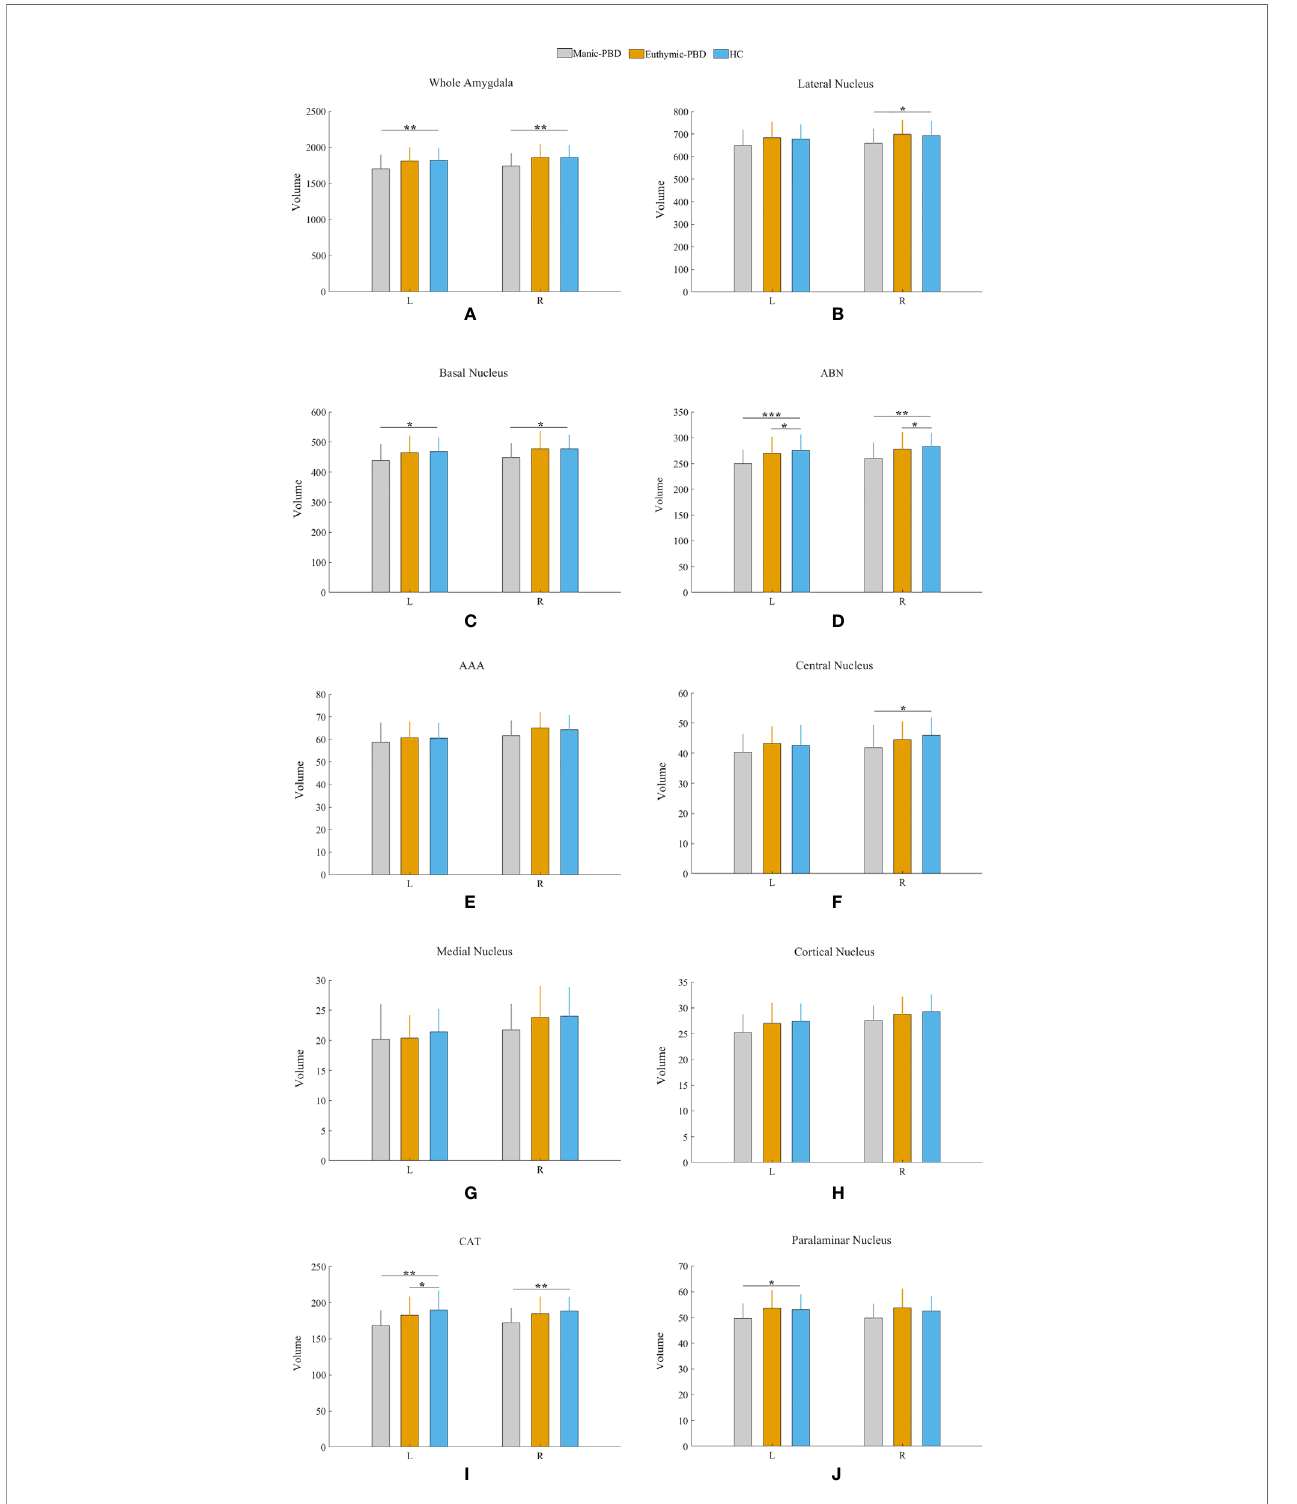
FIGURE 2 | Pairwise comparison of volumes in the manic PBD group, euthymic PBD group, and healthy control group ( A ,Whole Amygdala volume; B , Lateral Nucleus volume; C , Basal Nucleus volume; D , ABN volume; E , AAA volume; F , Central Nucleus volume; G , Medial Nucleus volume; H , Cortical Nucleus volume; I , CAT volume; J , Paralaminar Nucleus volume). The Y-axis represents the mean volume of amygdala and its subnuclei in each group. Unit: mm 3 . * p < 0.05; **p < 0.01. L, left amygdala; R, right amygdala; ABN, accessory basal nucleus; AAA, anterior amygdaloid area; CAT, cortico-amygdaloid